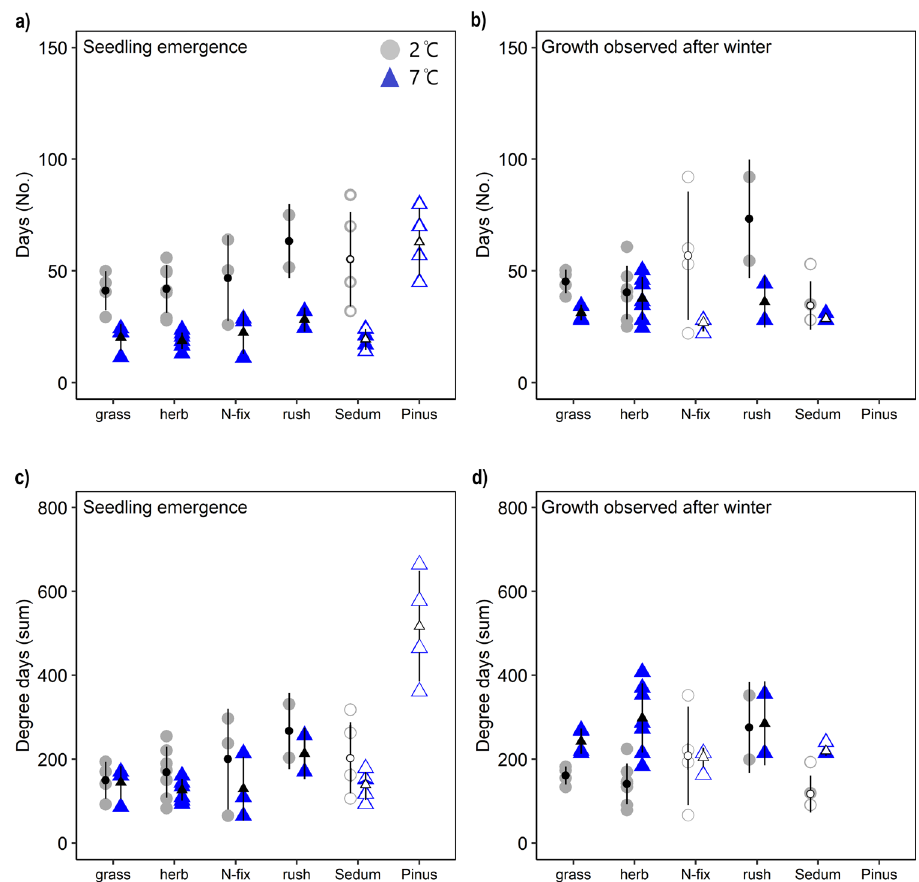
Fig. 1 Time and temperature requirements. Time and degree day sums required for germination of the main plant types under Antarctic growing season temperatures (2 °C; grey circles) and climate warming (7 °C; blue triangles) in Antarctic soil. a Number of days required to fi rst germination and b number of days required for growth after winter. c Degree day sums required for the fi rst germination and d number of degree day sums required for growth after winter. Grey circles and blue triangles represent species-speci fi c means within each plant type (grass: 4, herb: 7, N- fi xing plants: 3 and rushes: 2), with the exception of Sedum album and Pinus sylvestris where ‘ open ’ data points represent experimental pots ( n = 4 – 5) and for N- fi xing plants after winter when only Astragalus cruckshanksii grew ( n = 4 – 5). Black symbols represent the mean with SD as error bars. For a complete species list see Supplementary Tables 1 and 2.